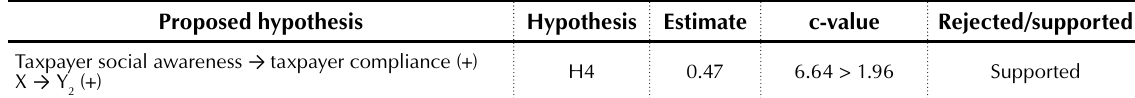
Table 4. Path coefficient for social awareness has a positive and significant effect on tax compliance